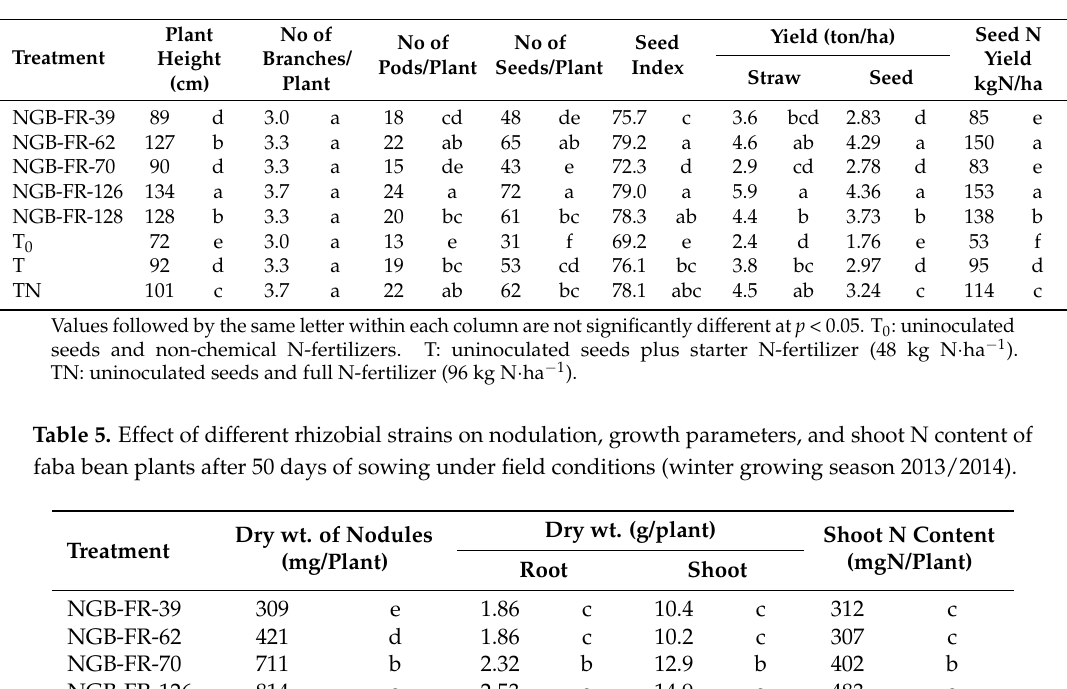
Table 4. Effect of different rhizobial strains on different growth parameters and yield of faba bean plants under field conditions (winter growing season 2012/2013).